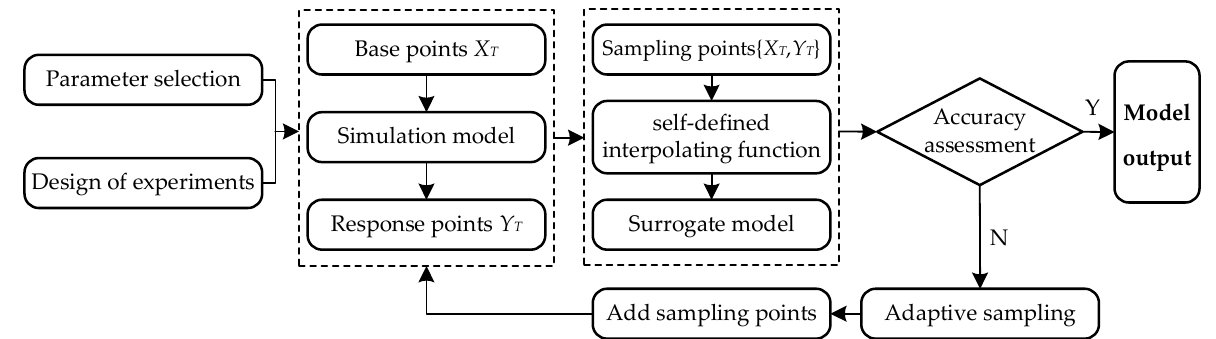
7 of 15 Figure 4. The relationship of design parameters and function range: ( a ) design parameter range; ( b ) function range. The OCs of the electromagnetic suction torque of the PMA satisfied the monotonicity with respect to the voltage and rotation angle if four boundary points were chosen; i.e., ( U m 0 , α n 0 ), ( U m 1 , α n 0 ), ( U m 0 , α n 1 ), and ( U m 1 , α n 1 ). ( U m 0 ≤ U ≤ U m 1 , α m 0 ≤ α ≤ α m 1 ), which could be obtained from Equation (4) as follows: 1 1 0 0 ( , )